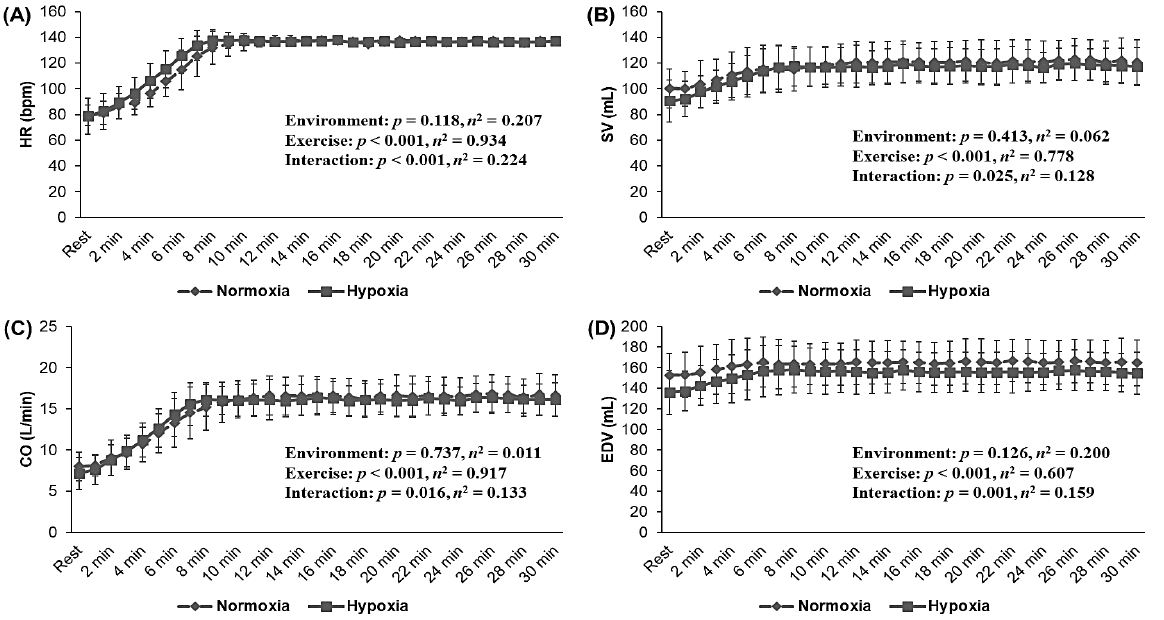
Figure 6. Changes in cardiac function during 30 min of the endurance exercise at the same relative exercise intensity (70%HRmax) under normoxia (760 mmHg) and hypoxia (526 mmHg, simulated 3000 m). ( A ) HR, ( B ) SV, ( C ) CO, ( D ) EDV, ( E ) ESV, ( F ) EF. HRmax: maximal heart rate; HR: heart rate; SV: stroke volume; CO: cardiac output; EDV: end-diastolic volume; ESV: end-systolic volume, EF: ejection fraction. The bars indicate the mean ± S.D. Skeletal muscle oxygenation, measured using NIRS, reflects the dynamic balance be- tween local oxygen supply by microcirculation and oxygen consumption by the mito- chondria [27]. Endurance exercise under hypoxia decreases skeletal muscle oxygenation,